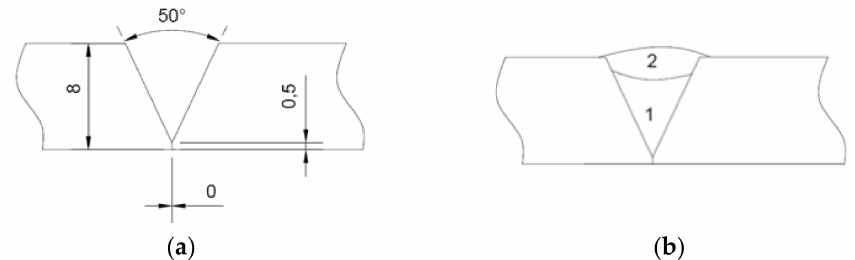
Figure 2. Schematic presentation of the weld joint: ( a ) joint design; ( b ) welding sequence. All dimensions in